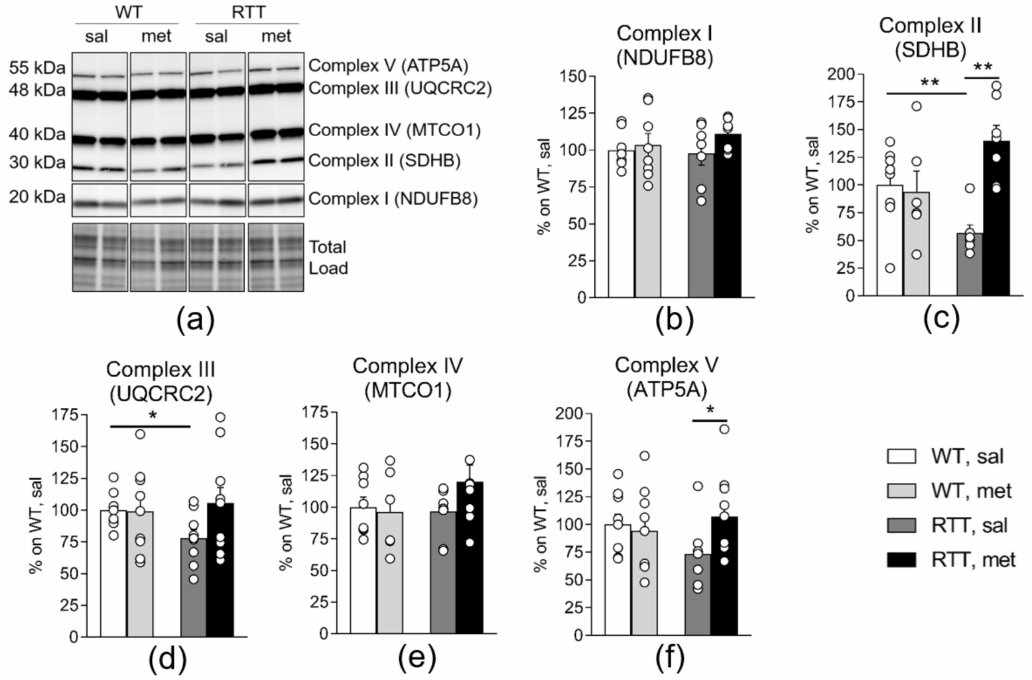
Figure 3. Metformin treatment normalizes decreased oxidative phosphorylation protein content in RTT mouse hippocampus. Protein expression levels of SDHB (subunit of Complex II) ( c ) and UQCRC2 (subunit of Complex III) ( d ) is decreased in the hippocampus of RTT mice. A trend towards a decrease was also observed for ATP5A (subunit of Complex V) ( f ) in RTT compared to WT controls. No genotype di ff erences were found for NDUFB8 (subunit of Complex I) ( b ) and MTCO1 (subunit of Complex IV) ( e ). Metformin treatment normalized protein expression levels of SDHB (subunit of Complex II) ( c ) and ATP5A (subunit of Complex V) ( f ) in RTT mice. Representative blot is shown in ( a ). N = 9–11. Data are mean ± SEM normalized for WT, sal. Statistical significance was calculated by two-way ANOVA, with Tukey’s post hoc test. * p < 0.05, ** p < 0.01. WT: wild-type mice; RTT: MeCP2-308 heterozygous female mice; sal: saline; met: metformin; NDUFB8: NADH:Ubiquinone Oxidoreductase Subunit B8; SDHB: Succinate Dehydrogenase Complex Iron Sulfur Subunit B; UQCRC2: Ubiquinol-Cytochrome C Reductase Core Protein II; MTCO1: mitochondrially encoded cytochrome c oxidase I; ATP5A: ATP Synthase, H + Transporting, Mitochondrial F1 Complex.